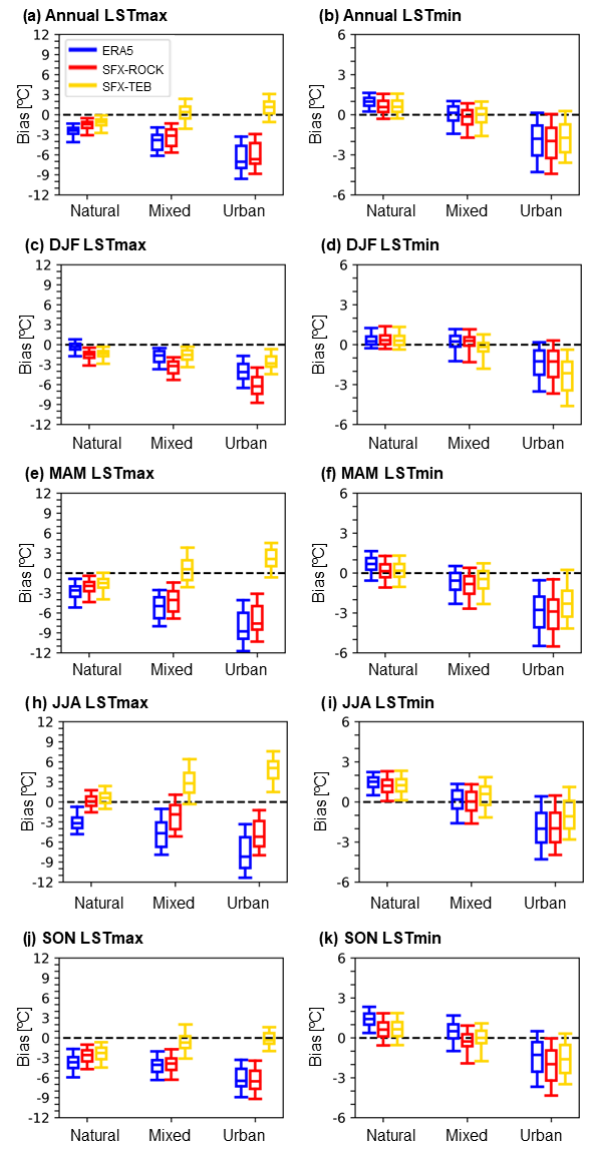
Figure 3. Box plots of the LST bias computed over the 2004–2018 period for the daytime (left column) and nighttime (right column) for ERA5 (blue), SFX-ROCK (red), and SFX-TEB (yellow). The box plots represent the bias spread for grid boxes classified as nat- ural surfaces (grid boxes with urban fraction below 0.33), mixed surfaces (grid boxes with urban fraction between 0.33 and 0.66), and urban surfaces (grid boxes with urban fractions above 0.66). From top to bottom, the rows represent the bias computed for the full annual cycle, i.e., DJF, MAM, JJA, and